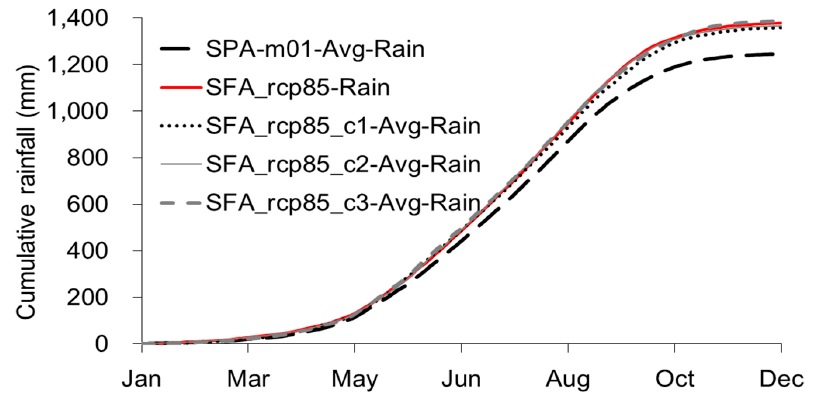
Figure 9. The 25-year averaged cumulative rainfall of the Mekong basin for the present and future climate experiments.